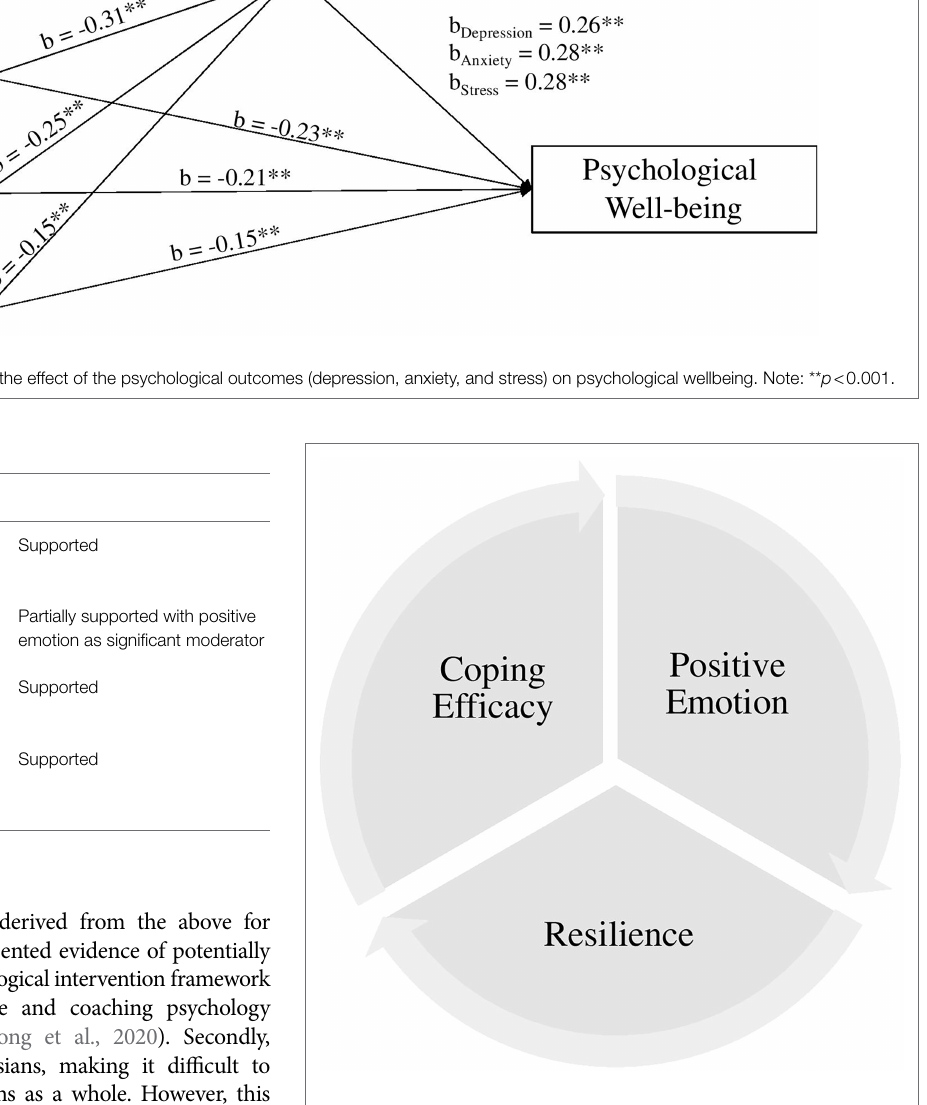
FIGURE 5 | Positive emotion-resilience-coping efficacy (PERCE)